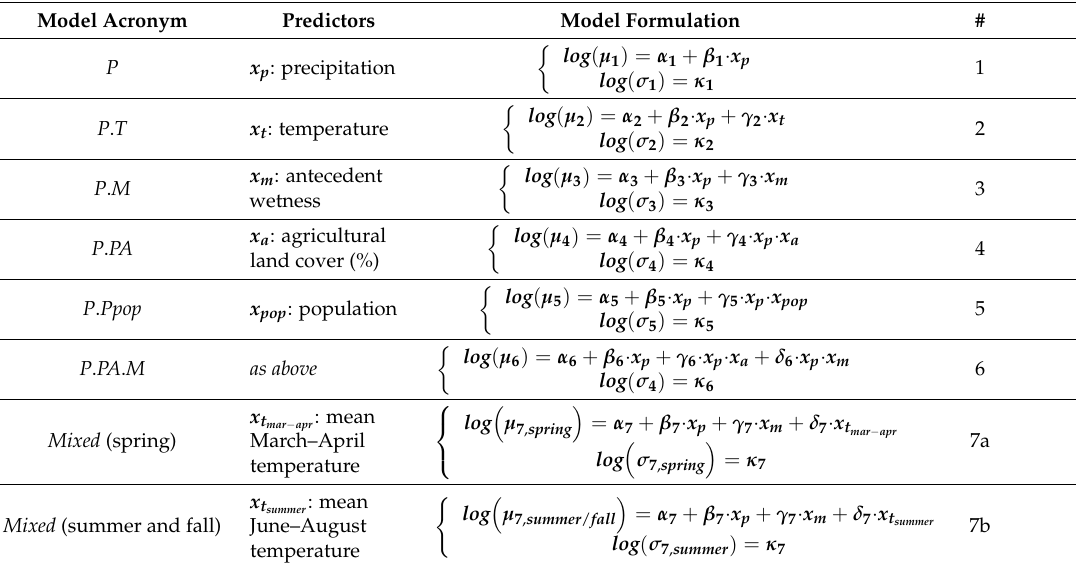
Table 1. Description of the seven models, their predictors and